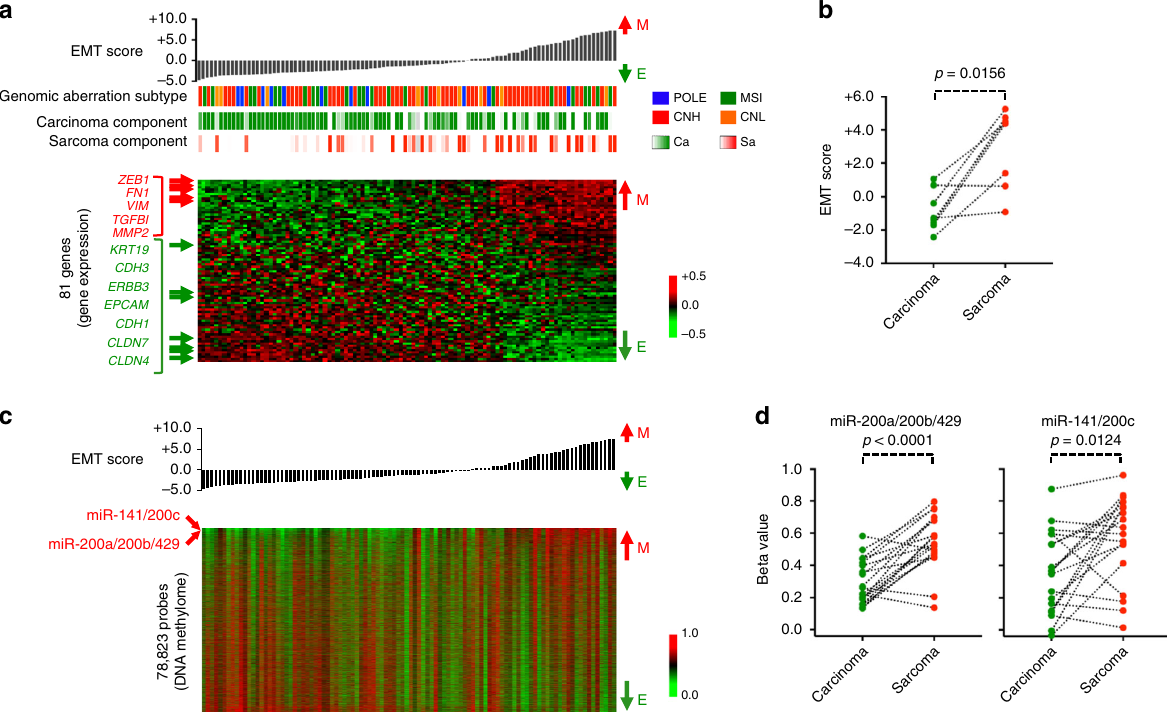
Fig. 7 Epithelial-mesenchymal transition (EMT) in the transcriptome and DNA methylome of carcinosarcoma (CS) tumors. a Relationship among EMT score, EMT gene expression, genomic aberration subtype, and carcinoma or sarcoma content in a CS tumor. CS samples are sorted according to EMT score, calculated by the fi rst principal component of 81 EMT marker genes. Red and green indicate high and low expression of the genes in the heatmap. Representative epithelial and mesenchymal genes are shown to the left of the heatmap in green and red, respectively. Color codes for the genomic aberration subtype are as follows: POLE, blue; MSI, green; CNH, red; and CNL, orange. Carcinoma and sarcoma content in a CS sample is shown by gradients of green and red, respectively. E; epithelial, M; mesenchymal. b EMT score of micro-dissected carcinoma or sarcoma components. The EMT scores were computed with RNA-seq data derived from the carcinoma and sarcoma components separately captured by laser capture microdissection. The Wilcoxon signed rank test was used to evaluate statistical signi fi cance. c DNA methylome correlated with EMT score across CS samples. CpG probes were selected by variable methylation within the top 20% variance. The resultant 78,823-probe β -values were sorted according to EMT score and are shown as a heatmap. The positions of CpG sites for miR-141/200c and miR-200a/200b/429 are indicated beside the